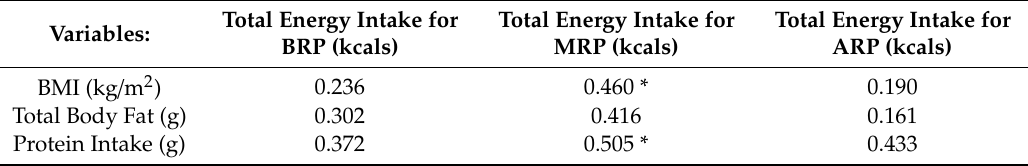
Figure 3. Among group differences in plant protein, animal protein, and animal-to-plant protein ratio intake from the three-day food record averages of study participants below ( n = 17), meeting ( n = 22), and above ( n = 23) the recommended-protein groups (below recommended-protein group (BRP), recommended-protein group (RP), and above recommended-protein group (ARP), respectively). Values are reported as mean ± standard error of the mean (SEM). * Denotes significant di ff erences among groups ( p ≤ 0.05). Table 4. Correlations between body mass index, total body fat percentage, and total protein intake with total energy intake.